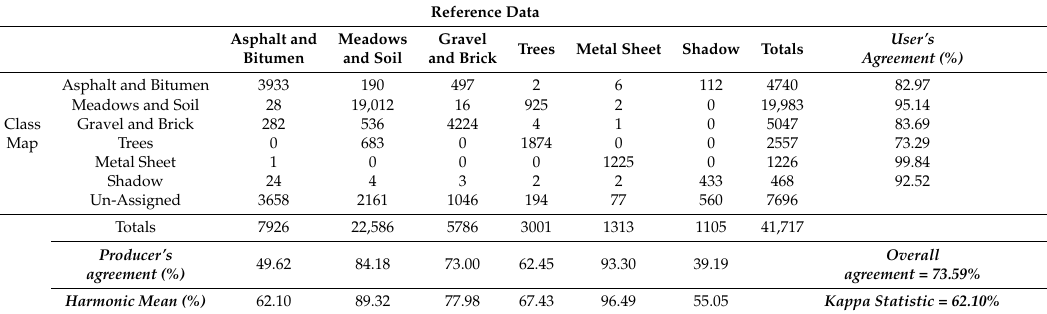
Table 3. Agreement matrix between reference and generated classification maps for Pavia.